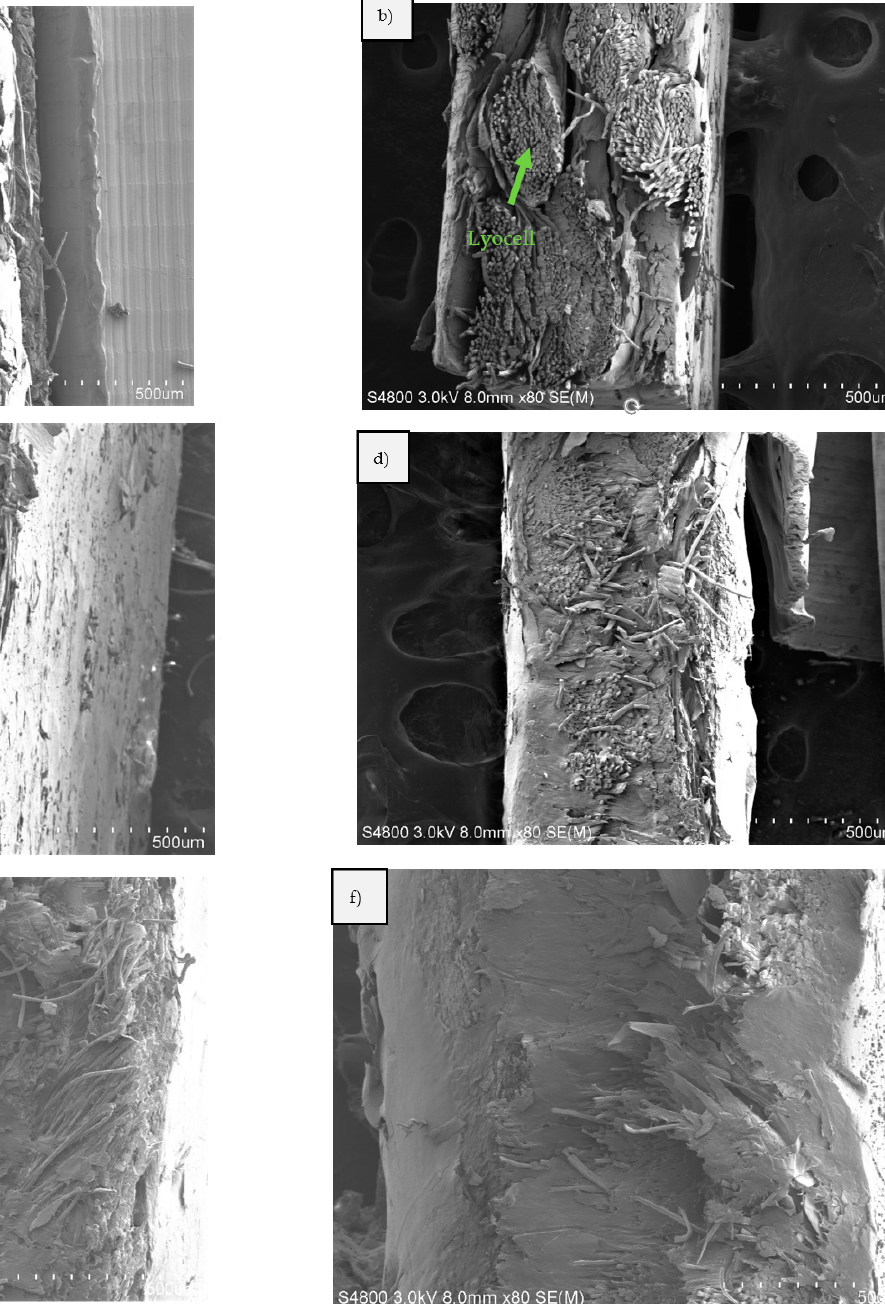
Figure 11. SEM pictures of the composites: ( a ) S-ACC, ( b ) L-ACC, ( c ) S-BC2, ( d ) L-BC2, ( e ) S-BC4 and ( f ) L-BC4, with a magnification of 80×.